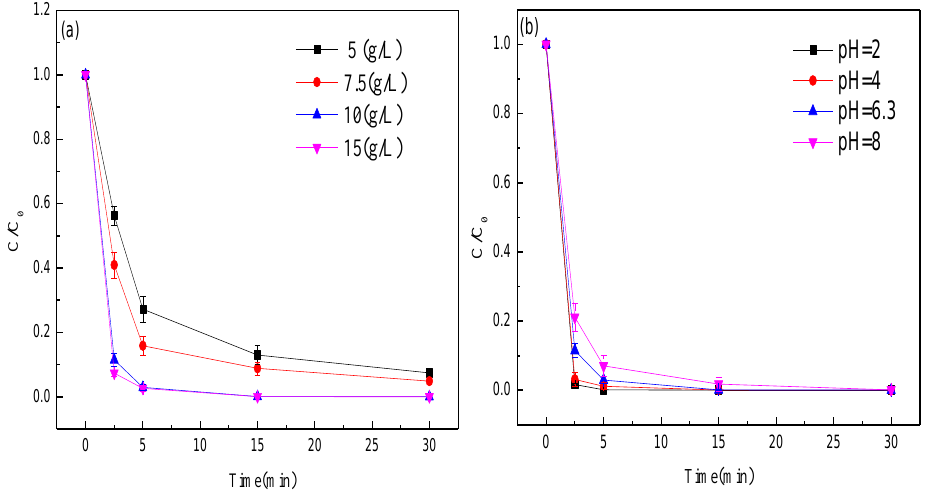
Figure 5. Effects of ( a ) dose of MEM, and ( b ) aqueous pH on the decolorization efficiency of methyl orange.